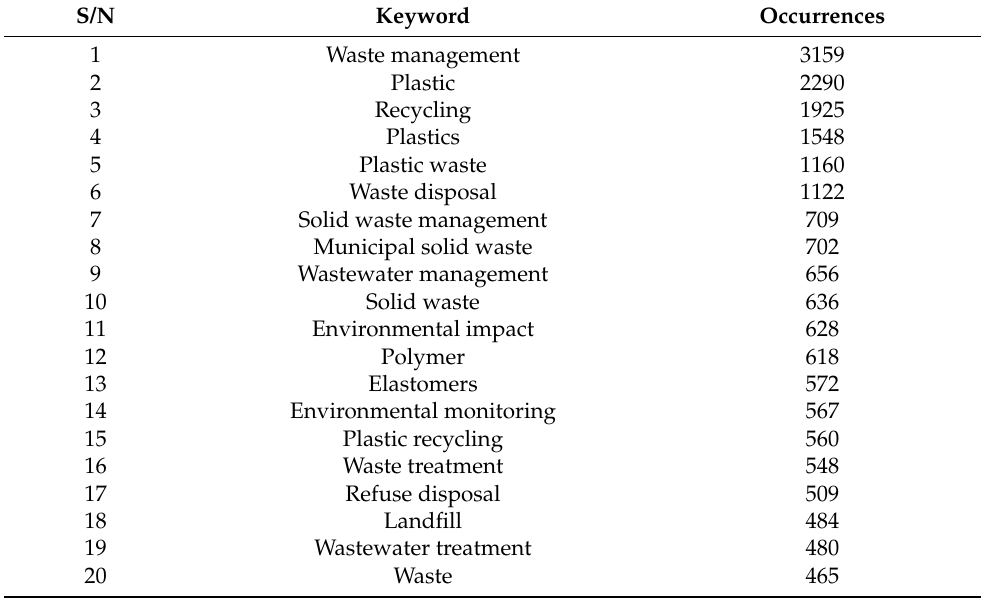
Table 2. The leading 20 most utilized keyword combinations in the related study